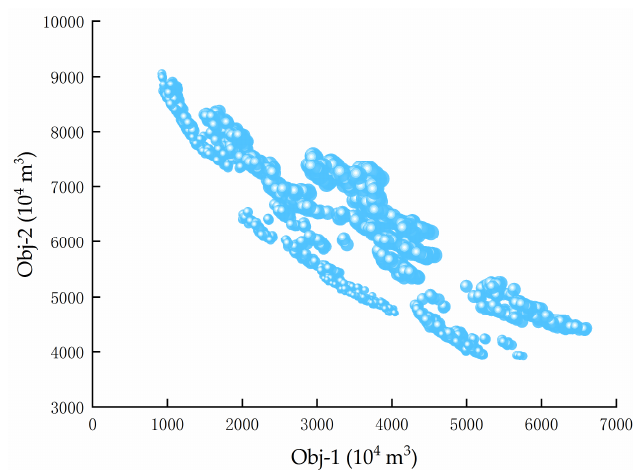
Figure 4. Bubble graph of irrigation and ecology, in which the bubble size represents the multi-year average power generation (Obj-3).